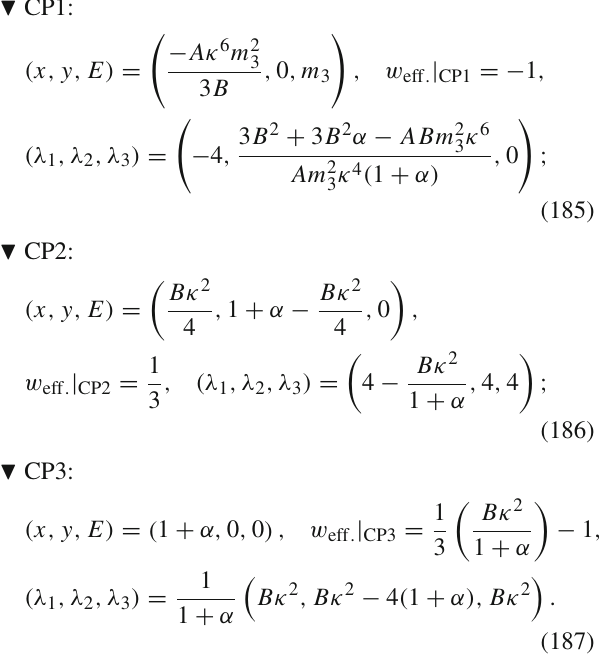
fying the constant parameters. The CPs and